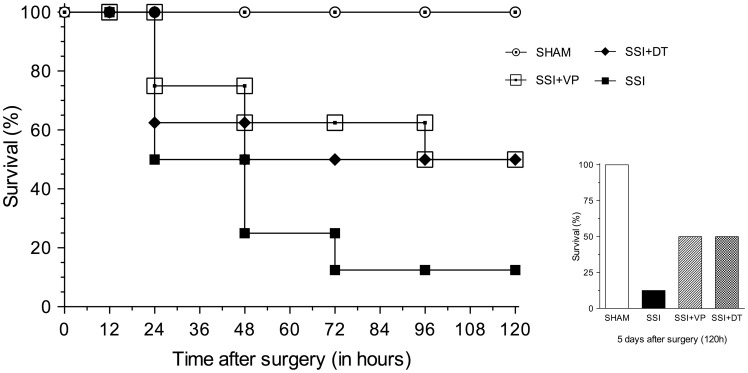
Verapamil and dantrolene improved survival rate in mice submitted to CLP-induced sepsis.Sham-operated untreated mice presented a 100% survival rate throughout the analyzed period of 120 hours. SSI mice had a survival rate of 50% at 24 hours after surgery, decreasing to 10% at 96 hours and remaining steady at this rate until 120 hours after surgery. In contrast, SSI mice treated with verapamil showed a survival rate around 75% at 24 hours, decreasing to 50% at 96 hours and remaining steady at this rate until the end of the experimental period. Similarly, SSI mice treated with dantrolene disclosed a survival rate around 60% at 24 hours, decreasing to 50% at 96 hours and remaining steady at this rate until 120 hours after CLP. The bar graph illustrates the survival rate for each group at 5 days after the surgical procedure. (n = 8 animals per group).